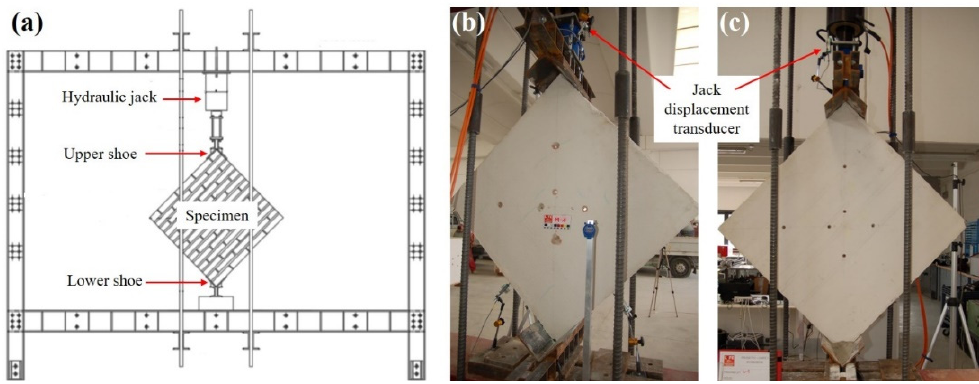
Figure 4. ( a ) Test set-up schematisation; ( b ) specimen GTRM-1 and ( c ) specimen BTRM-1 in the testing device. testing